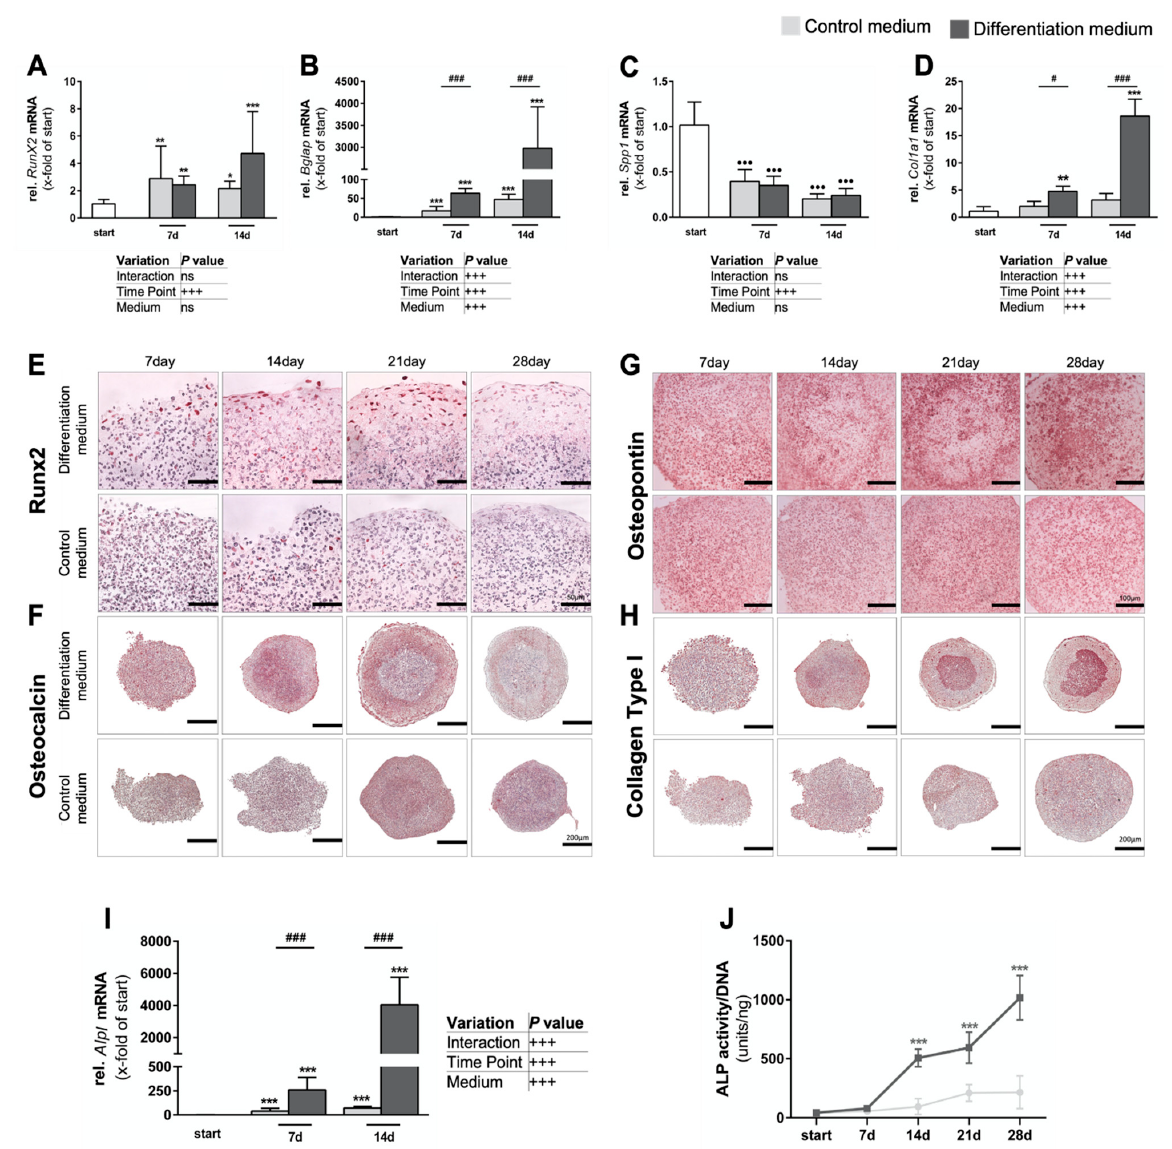
Figure 2. Expression of osteogenic markers . ( A – D ) Relative mRNA expression of selected differen- tiation markers during the first 14 days of culture, with tabular summary of analyses underneath. Shown are Runx2 ( A ), Bglap (osteocalcin) ( B ), Spp1 (osteopontin) ( C ), and Col1a1 ( D ). Significant differences were calculated by 2-way ANOVA ( n = 5), followed by Tukey post hoc test. ( E – H ) Cor- responding immunohistology. IHC staining against Runx2 ( E ), osteocalcin ( F ), osteopontin ( G ) and type I collagen ( H ). Representative staining from at least three spheroids ( n = 3) per condition; scale bars as indicated. ( I ) Changes in Alpl mRNA abundance until day 14 of culture and ( J ) respective enzymatic activity over 28 days. Significant differences were calculated by 2-way ANOVA ( n = 5) of BCY-transformed data followed by Tukey’s post hoc test ( I ) and Kruskal–Wallis ( n = 6) followed by Dunn’s post hoc test ( J ). # p < 0.05 ### p < 0.001 as indicated; * p < 0.05, ** p < 0.01, *** p < 0.001, ••• p < 0.001 vs. starting day. Data represent geometric mean ± 95%